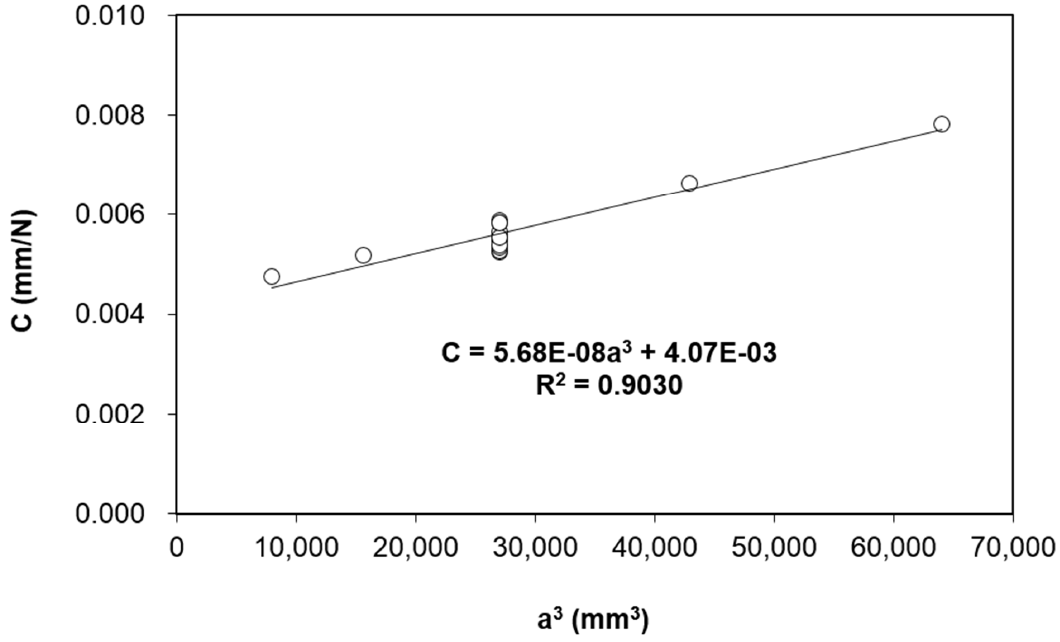
Figure 4. Compliance plot of the ENF test at different crack lengths. Table 2. Mode II interlaminar fracture toughness at various displacement rates, v .